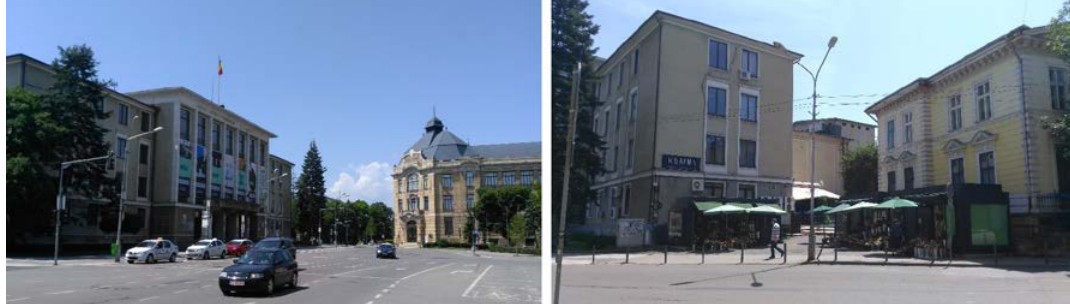
Figure 10: The central part of Lucian Blaga Square. Florists in Lucian Blaga Square Source: Emanuel- Cristian ADOREAN, 2016©